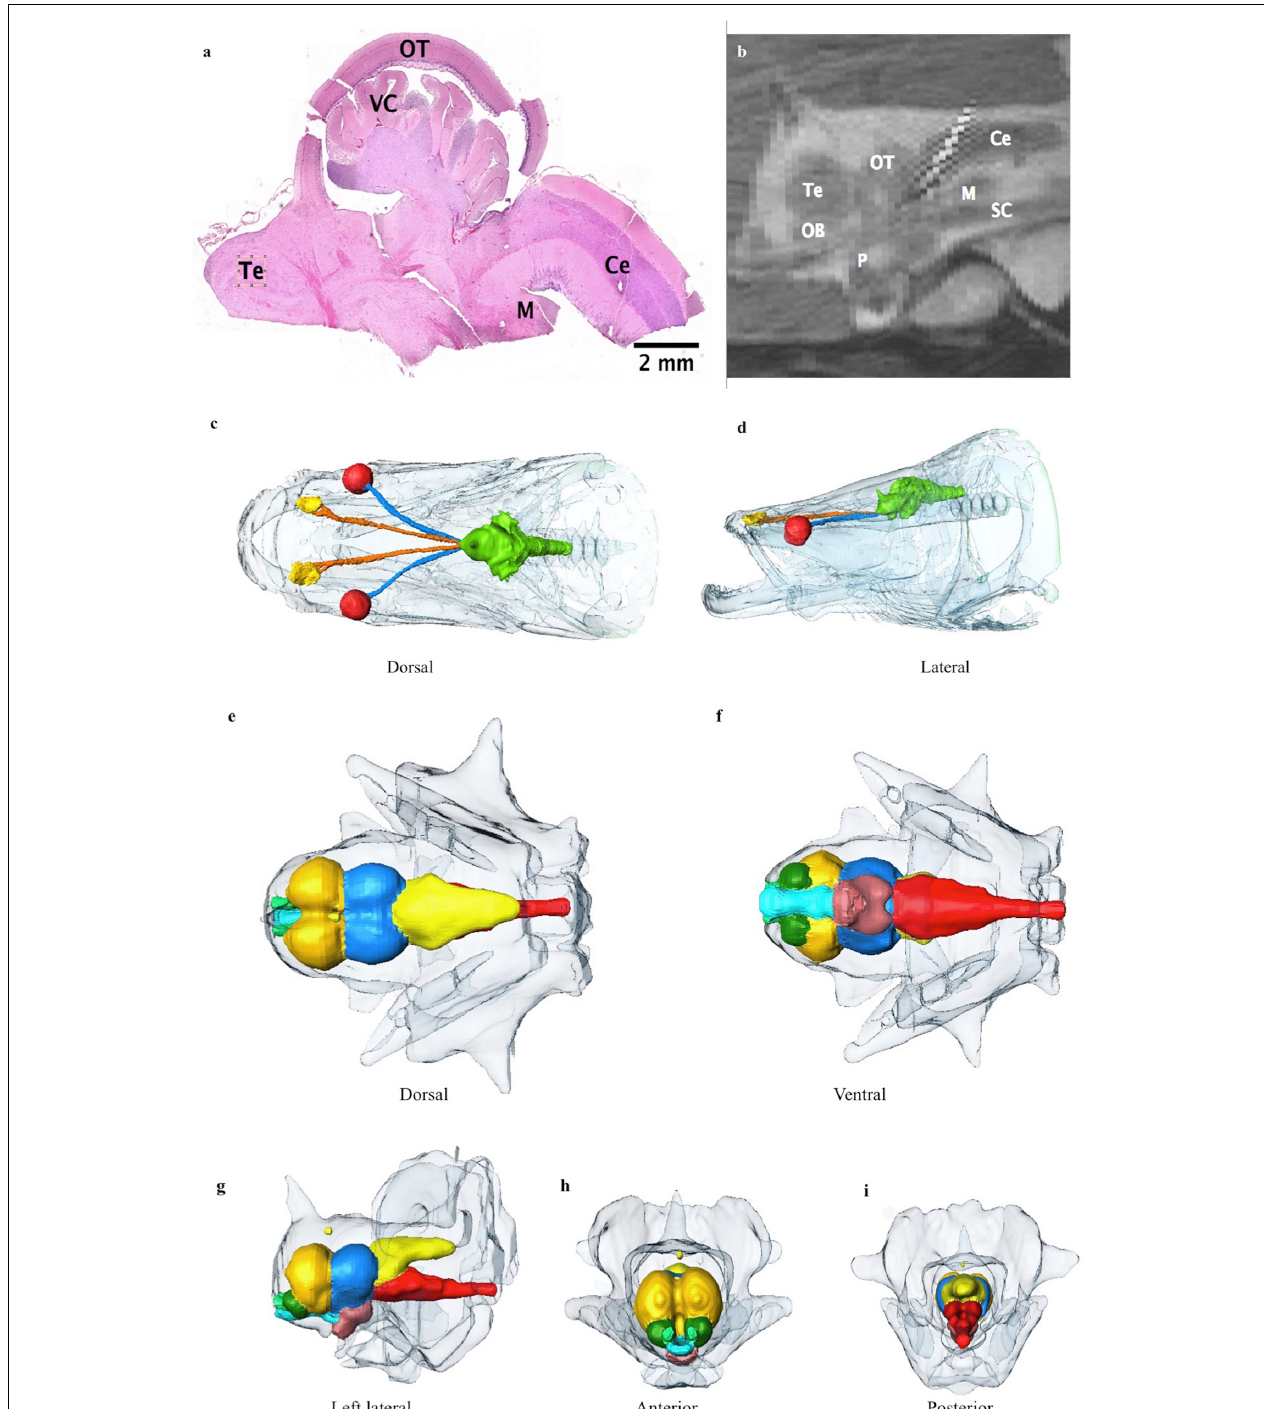
FIGURE 8 | (a) Photomicrograph showing the cerebellum (Ce), medulla (M), optic tectum (OT), valvula cerebelli (VC) and telencephalon (Te). (b) Sagittal midline T2 MR image through brain showing the cerebellum, optic tectum, telencephalon, olfactory bulb (OB), pituitary (P), spinal cord (SC) and medulla. Surrounding high signal is expansive cerebro-spinal fluid (CSF) space in which the brain is suspended. (c,d) Dorsal and lateral view 3D reconstructions of the head from CT data showing the extent of the CSF space encasing the brain (green), optic nerves (blue) and olfactory nerves (orange). Eyes are red, and lining of olfactory pits yellow. Other bony head structures are semi transparent head. (e–i) 3D reconstructions of the brain with large and complex CSF space surrounding brain (semitransparent surface). (e) Dorsal, (f) Ventral, (g) lateral, (h) anterior, and (i) Posterior view. Olfactory bulbs: green, telencephalon: dark yellow, hypothalamus: brown, optic tectum: blue, cerebellum: light yellow, medulla and proximal spinal cord: red, and proximal optic tract: turquoise.